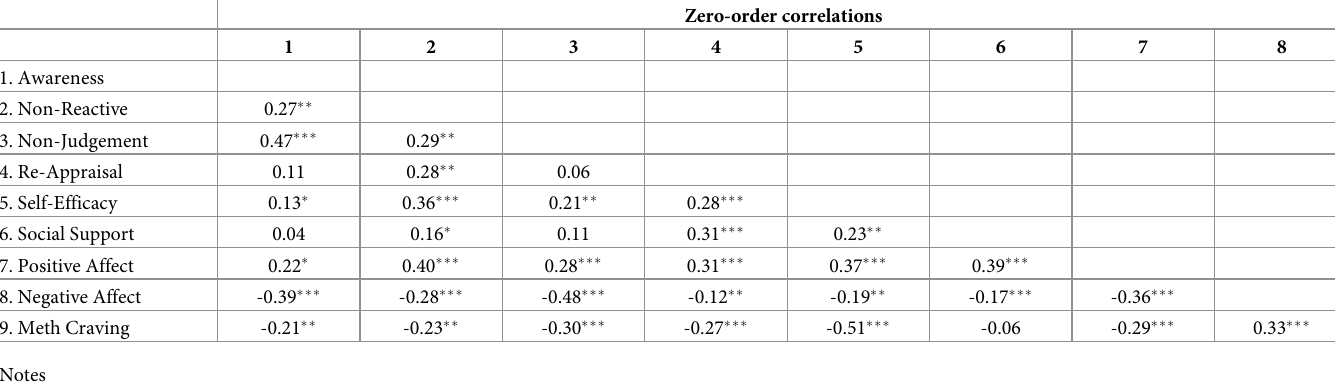
Table 1. Descriptive statistics and zero-order correlations between methamphetamine craving and the predictor